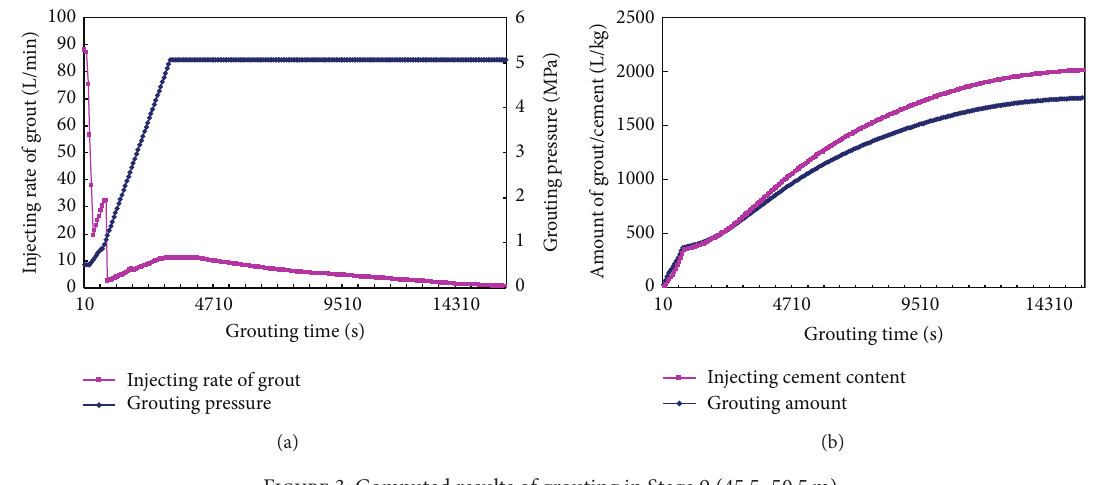
Figure 3: Computed results of grouting in Stage 9 (45.5–50.5 m). Table 1: Acoustic wave velocity and the permeability rate of drilling holes before grouting.